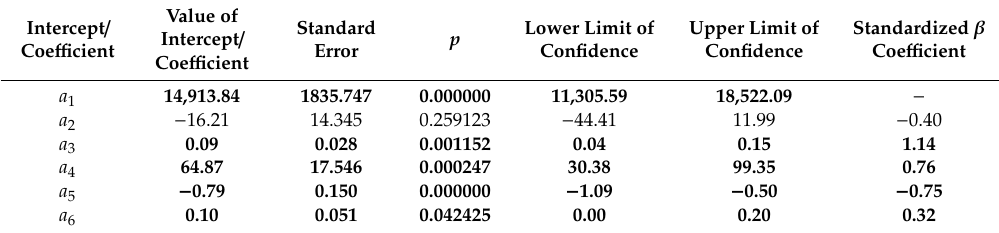
Table A2. Statistic evaluation of 3D model parameters of LHV (model 1).